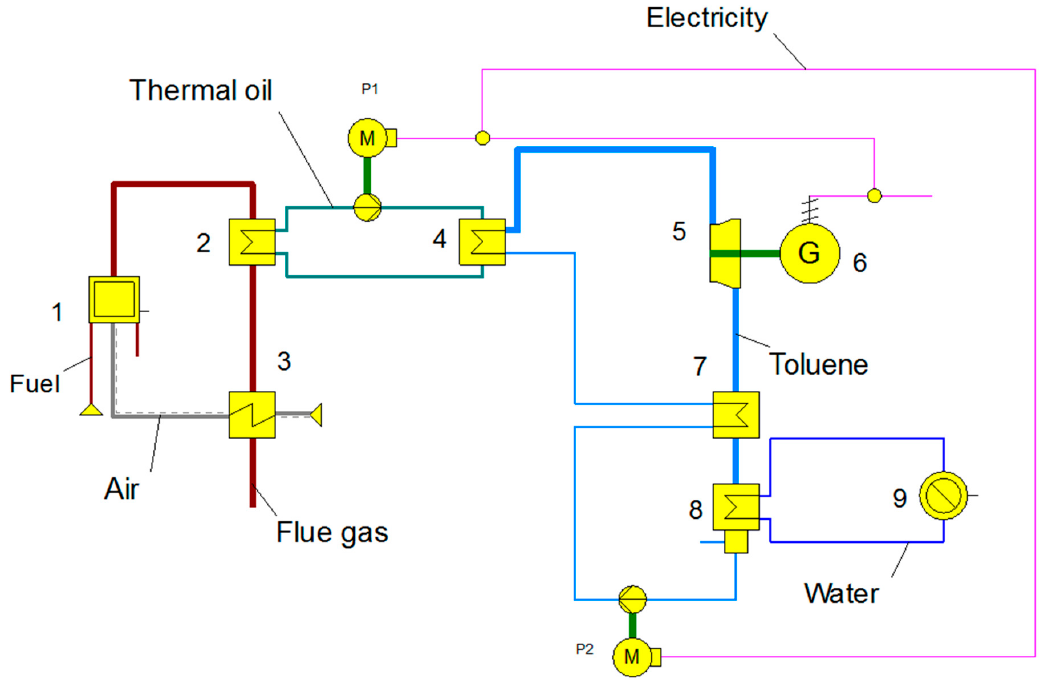
Figure 1. The authorial idea of the technological system, organic Rankine cycle, (ORC) with regeneration (1—combustion chamber, 2—heat exchanger from fumes to thermal oil,